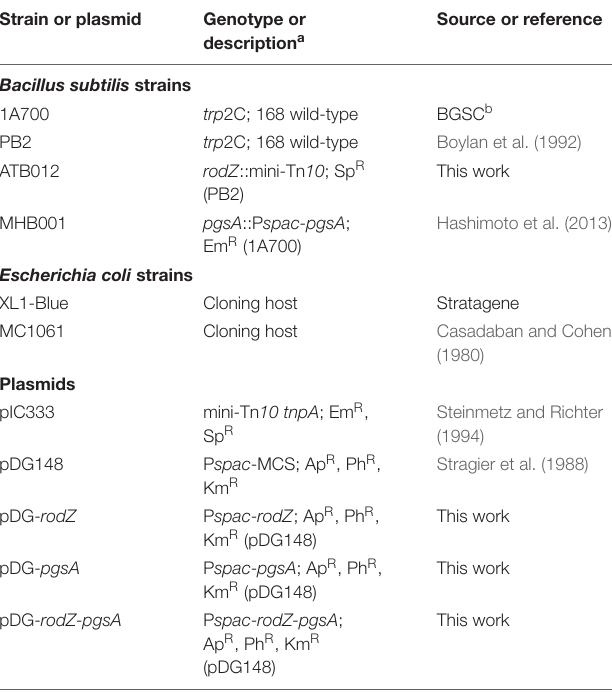
TABLE 1 | Plasmids and strains used in this